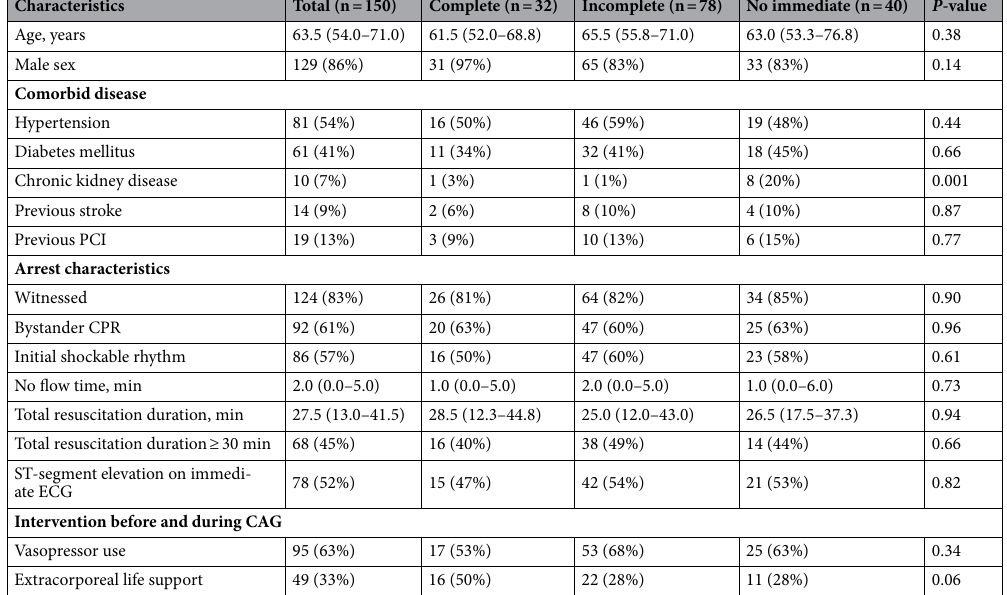
Table 1. Baseline characteristics of patients according to revascularization strategies. Values are presented as median (interquartile range) or number (percentage). CAG coronary angiography, CPR cardiopulmonary resuscitation, ECG electrocardiogram, PCI percutaneous coronary intervention.